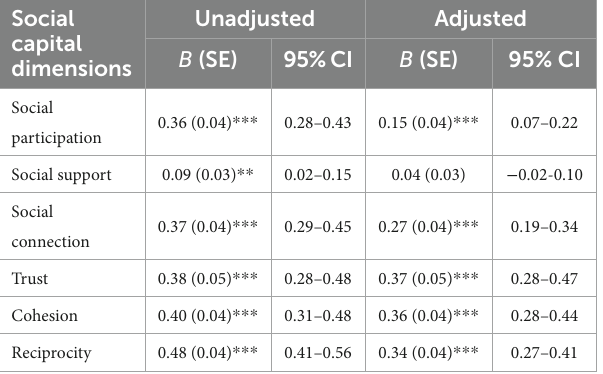
TABLE 3 The relationship between social capital and eHealth literacy using GLM (all participants).